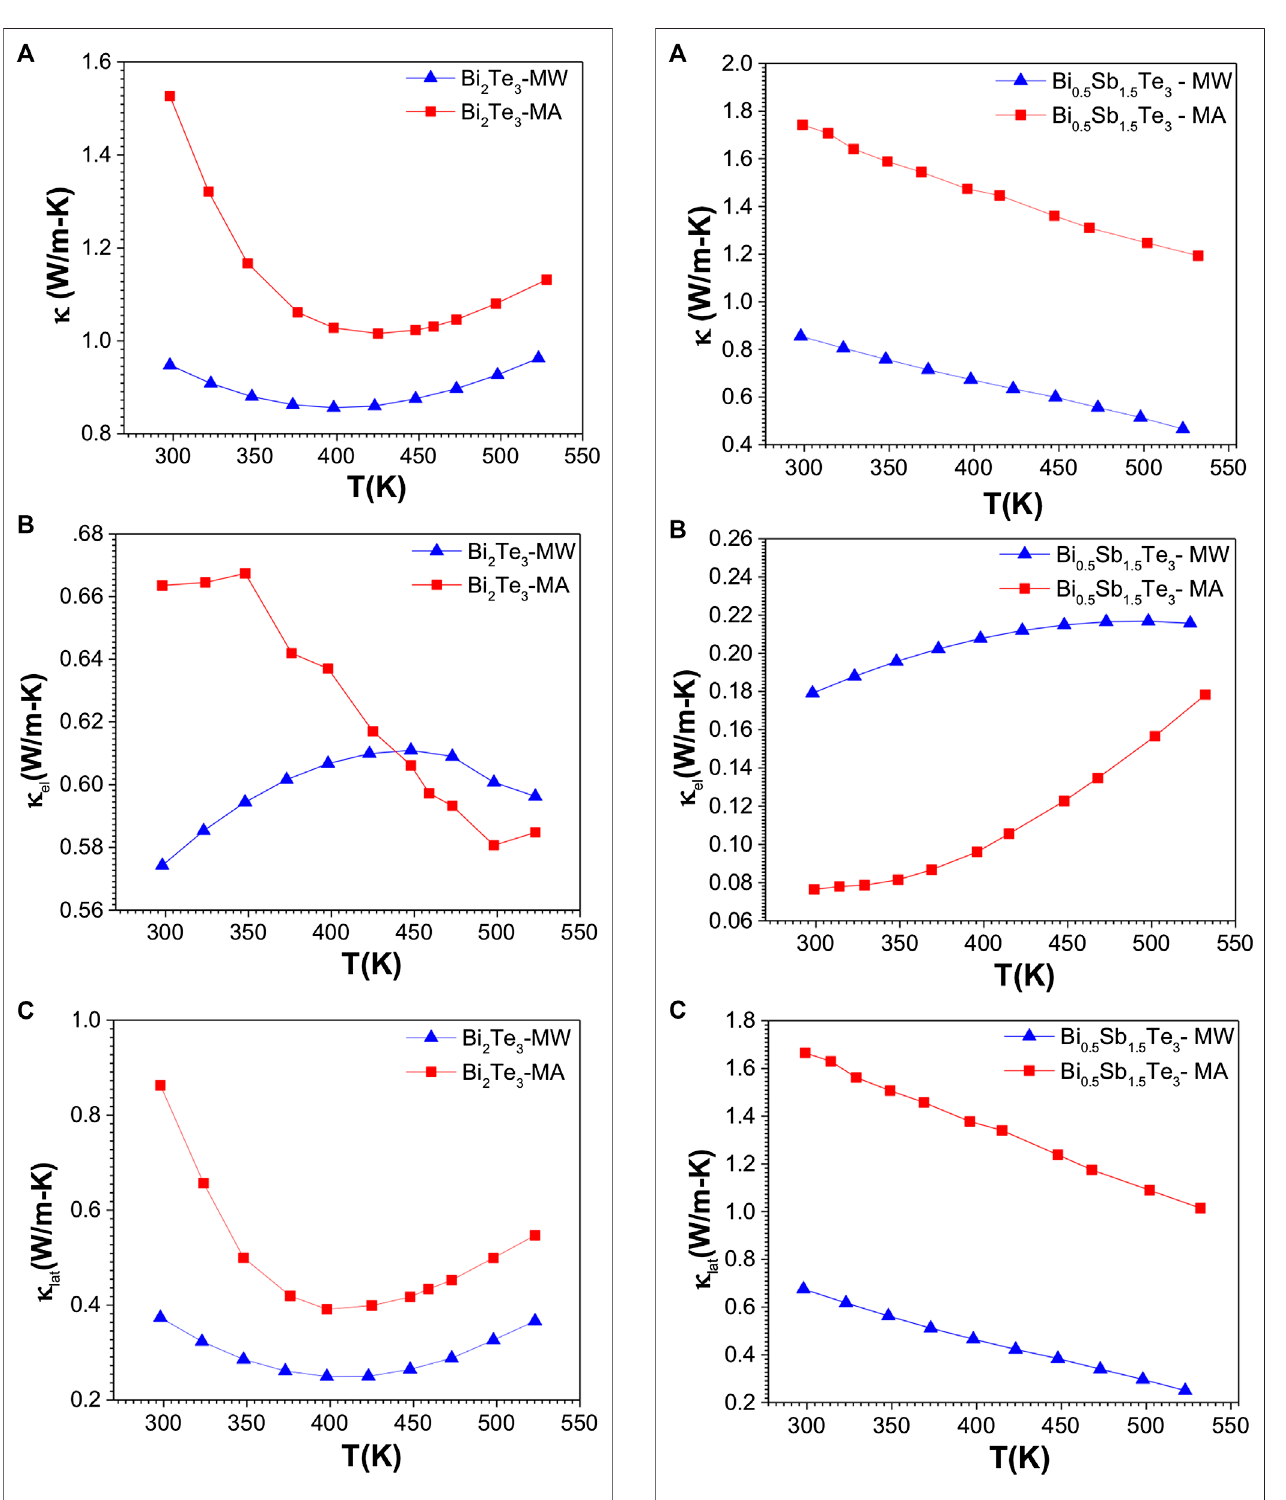
FIGURE7| Temperature-dependentthermalconductivityofSPsintered MA-B .5 Sb 1.5 Te 3 and MW-Bi 0.5 Sb 1.5 Te 3 samples: (A) total ( κ tot ), (B) electronic ( κ el ), and (C) lattice thermal conductivity ( κ lat